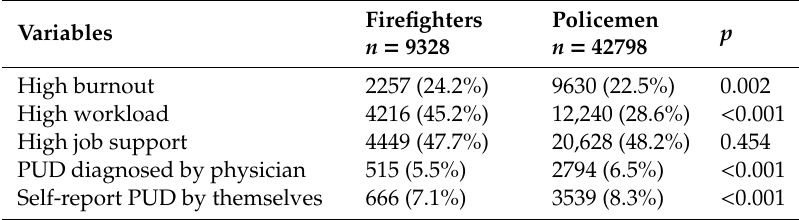
Table 3. Percentages of high burnout, high workload, high job support, and PUD among firefighters and